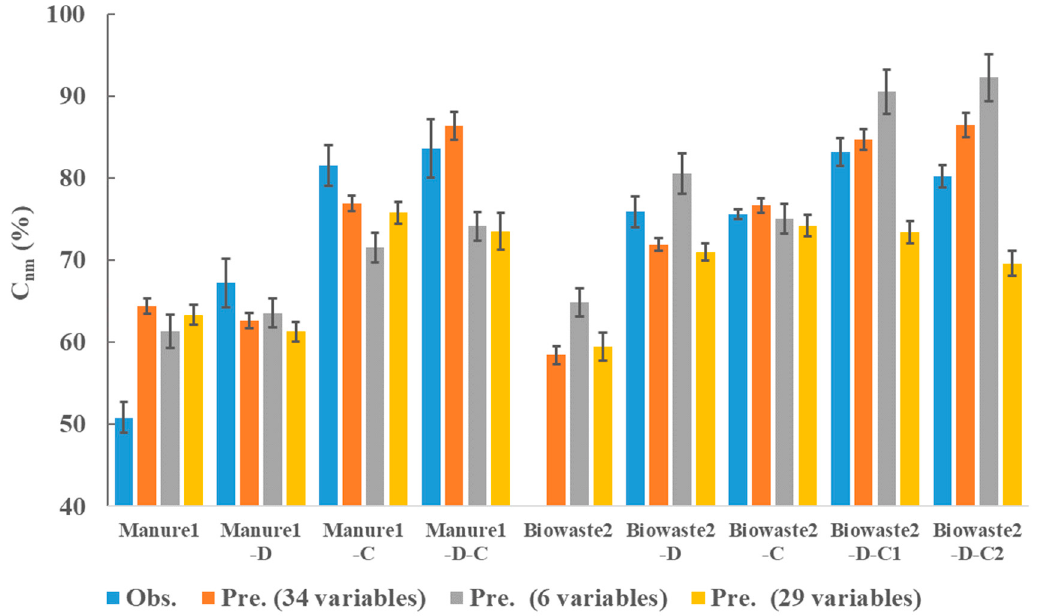
Figure 6. The observed non-mineralized carbon (C nm , %) values vs. predicted values. The blue, orange, grey, and yellow bars represent observed C nm value, predicted C nm values using both accessibility and complexity variables ( n = 34), using only the carbon content of OM plus accessibility variables ( n = 6), and using only the carbon content of OM plus complexity variables ( n = 29), respectively. C nm —non-mineralized C (%) of OM in the soil; D—digestate; C—compost.